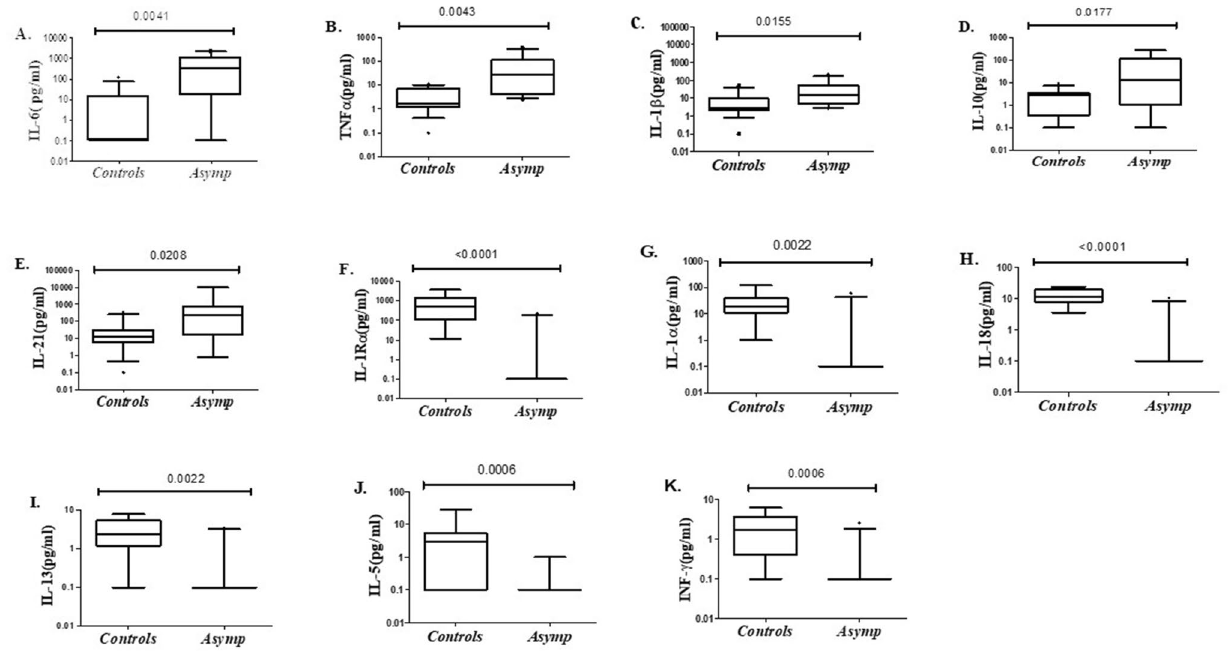
Figure 5. Circulating levels of cytokines in plasma of COVID-19 cases and controls. Plasma from COVID-19 Asymptomatic (n = 12) and healthy Controls (n = 13) were tested using the Th1/Th2 25-plex Procartaplex assay. ( A ) IL-6, ( B ) TNF-α, ( C ) IL-1β, ( D ) IL-10, ( E ) IL-21, ( F ) IL-1Rα, ( G ) IL-1α, ( H ) IL-18, ( I ) IL-13, ( J ) IL-5 and ( K ) IFN-γ. Data is shown as median values (horizontal line) with IQR (10th–90th quartile). Data between group was analysed using the Mann–Whitney U non-parametric assay and p values < 0.05 are indicated as significantly